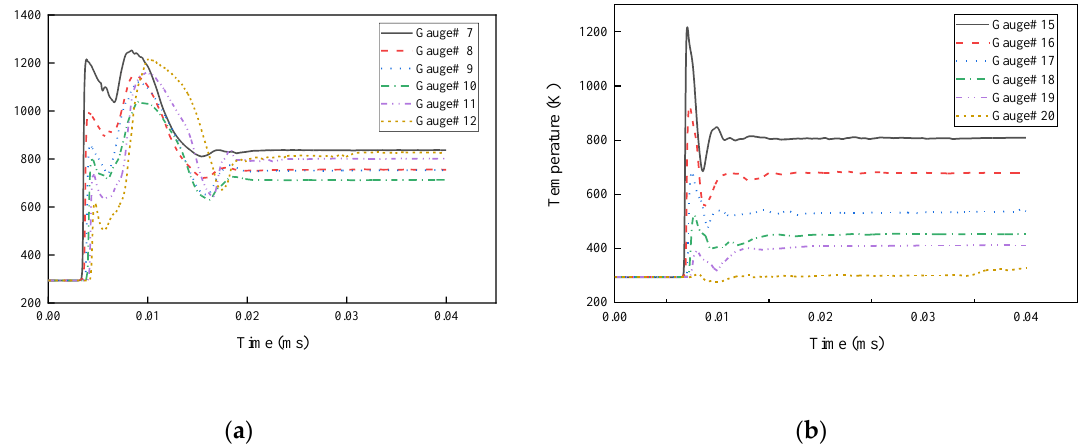
Figure 8. Temperature of the reactive composite jet change with time: ( a ) middle of the reactive liner ( b ) and bottom of the reactive liner.